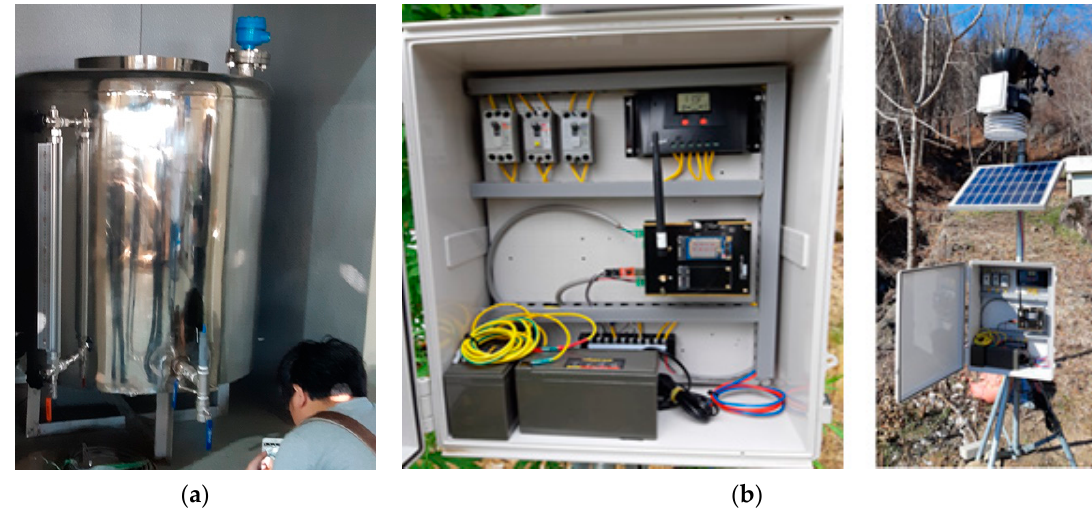
Figure 9. Prototype of Acer mono sap collection H/W. ( a ) smart sap collection tank; ( b ) energy harvesting device.